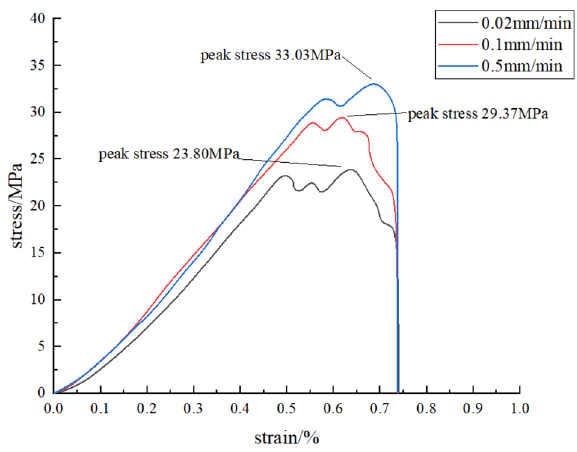
Figure 5. Loading curves at different loading rates.